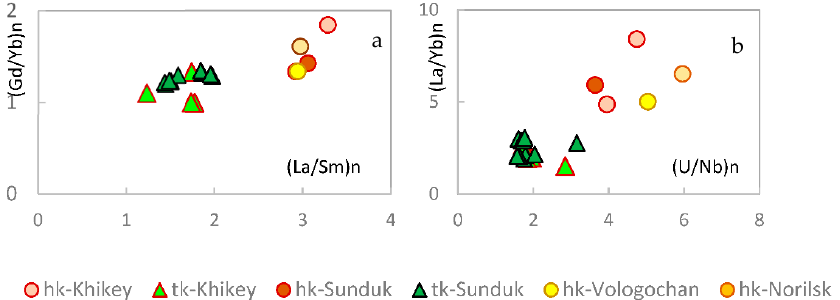
Figure 12. Diagrams (La/Sm)n vs. (Gd/Yb)n ( a ) and (U/Nb)n vs. (La/Yb)n ( b ) for the Khakanchansky and Tuklonsky Formations.